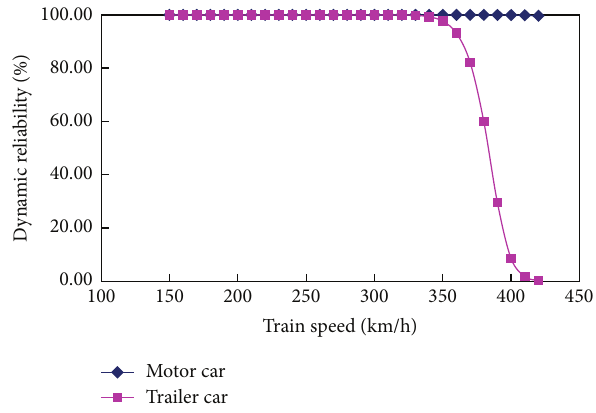
Figure 14: Dynamic reliability for wheel load decrement ratio with respect to train